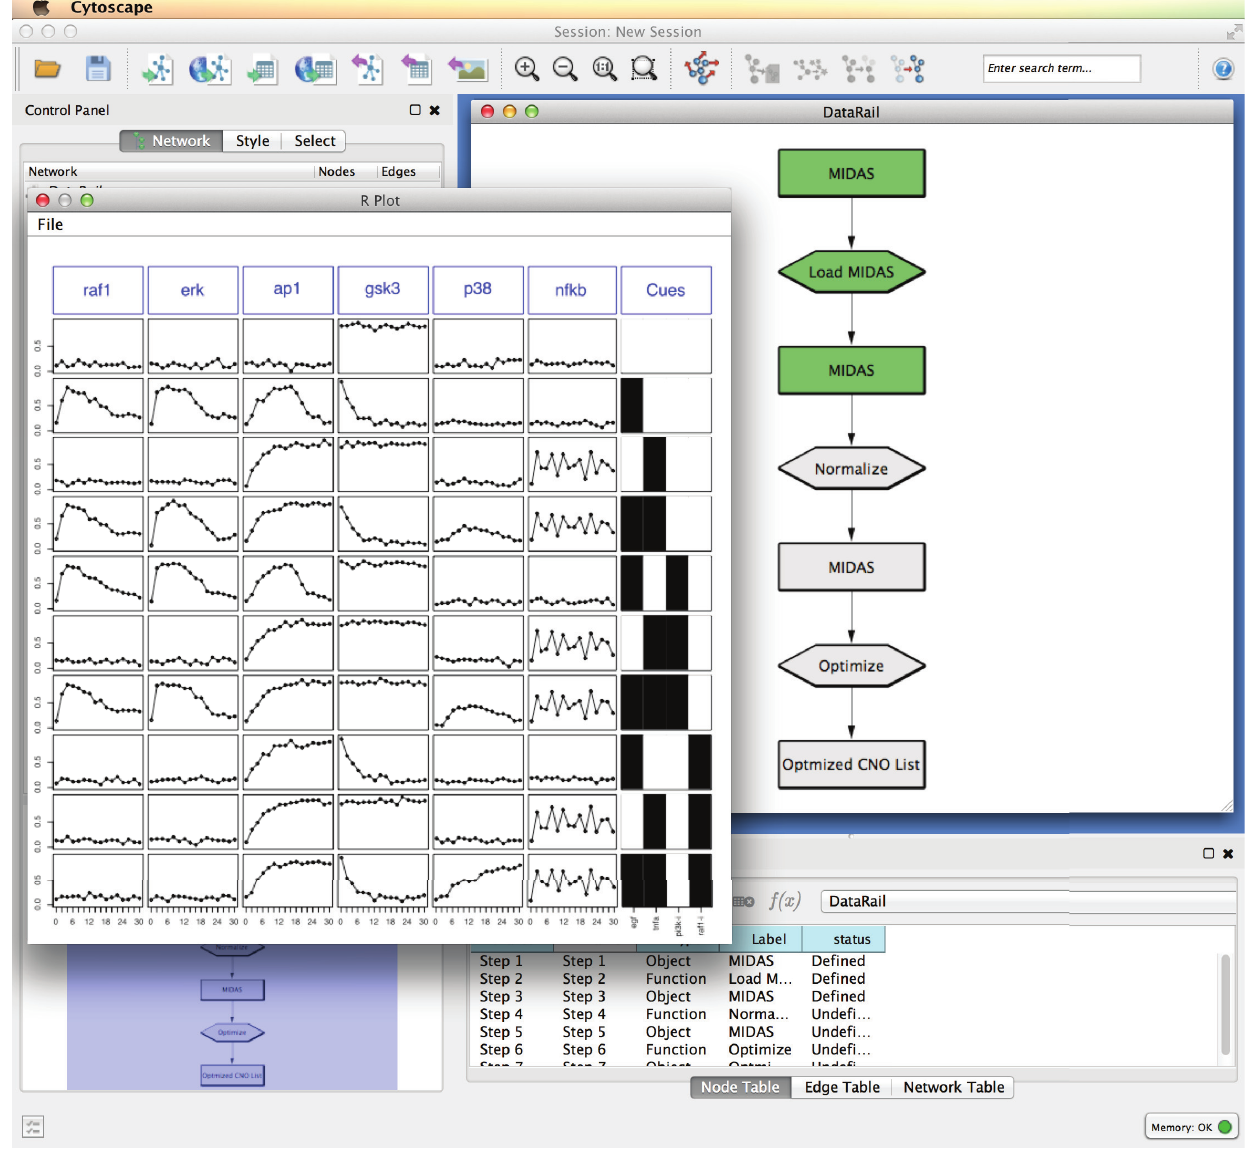
Figure 2. The Cyrface implementation of the DataRail 12 workflow. The rounded rectangles represent the MIDAS files containing the experimental data at a given state. Hexagon nodes represent functions such as load or normalise. Green identifies steps that were successfully executed and grey identifies those that were not run yet. The data-set shown represents the normalised values of the protein activity state of a set of proteins (columns) under different stimulatory conditions (rows).